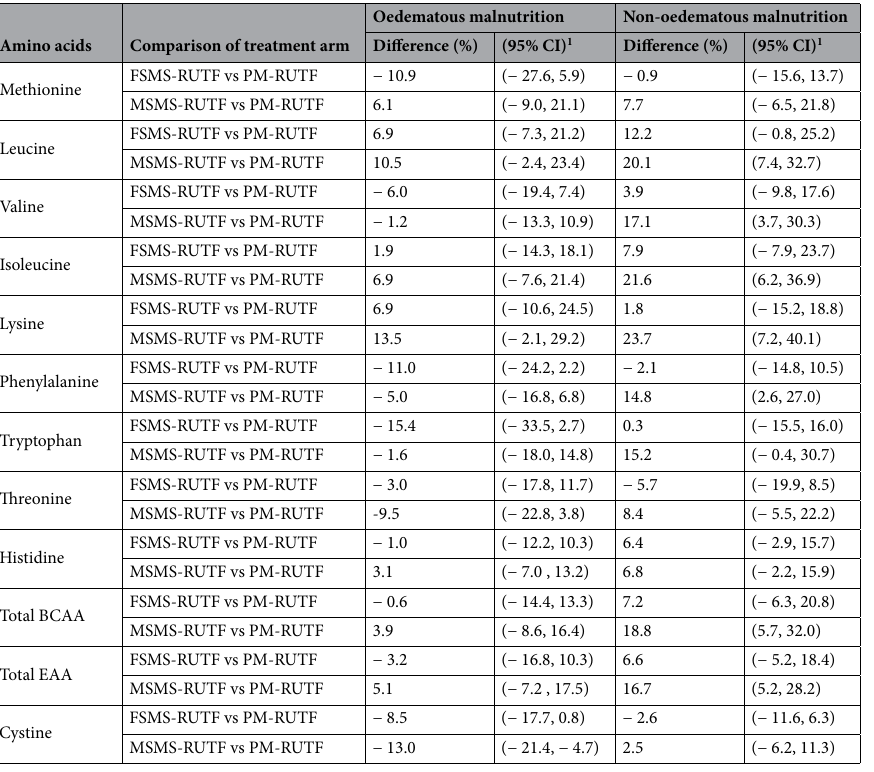
Table 3. Testing the non-inferiority of the plasma amino acid concentrations at discharge between the PM-RUTF arm and the FSMS-RUTF and MSMS-RUTF arms in each SAM subgroup. The point estimate and 95% CI of the differences in plasma amino acid concentrations at discharge between the FSMS-RUTF and PM-RUTF arms and between the MSMS-RUTF and PM-RUTF arms by using the SAM subgroup data. The differences are shown as relative values based on the plasma amino acid concentrations of the PM-RUTF arm at discharge. 1 CIs were estimated by simultaneous inference procedures in a mixed model. The non-inferiority margin was -25% of the plasma amino acid concentration of the PM-RUTF arm at discharge. Therefore, the lower limit of 95% CI above -25% indicated non-inferiority. All specimens described as “Analysis” in Fig. 2 were used for this